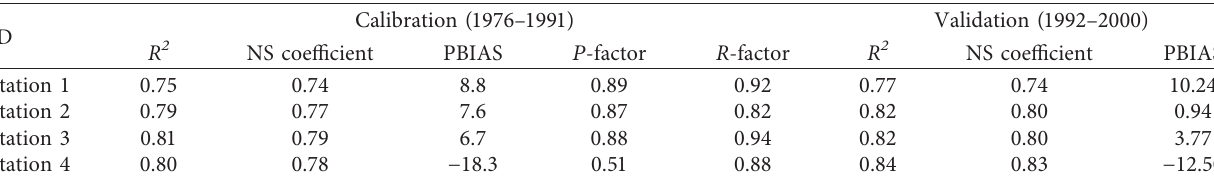
Figure 3: Comparisons of daily streamflow simulations (black lines) with observations (gray areas) during calibration (1976–1991) and validation (1992–2000) periods. Table 6: Calibration (1976–1991) and validation (1992–2000) performance metrics for daily runoff at the four monitoring